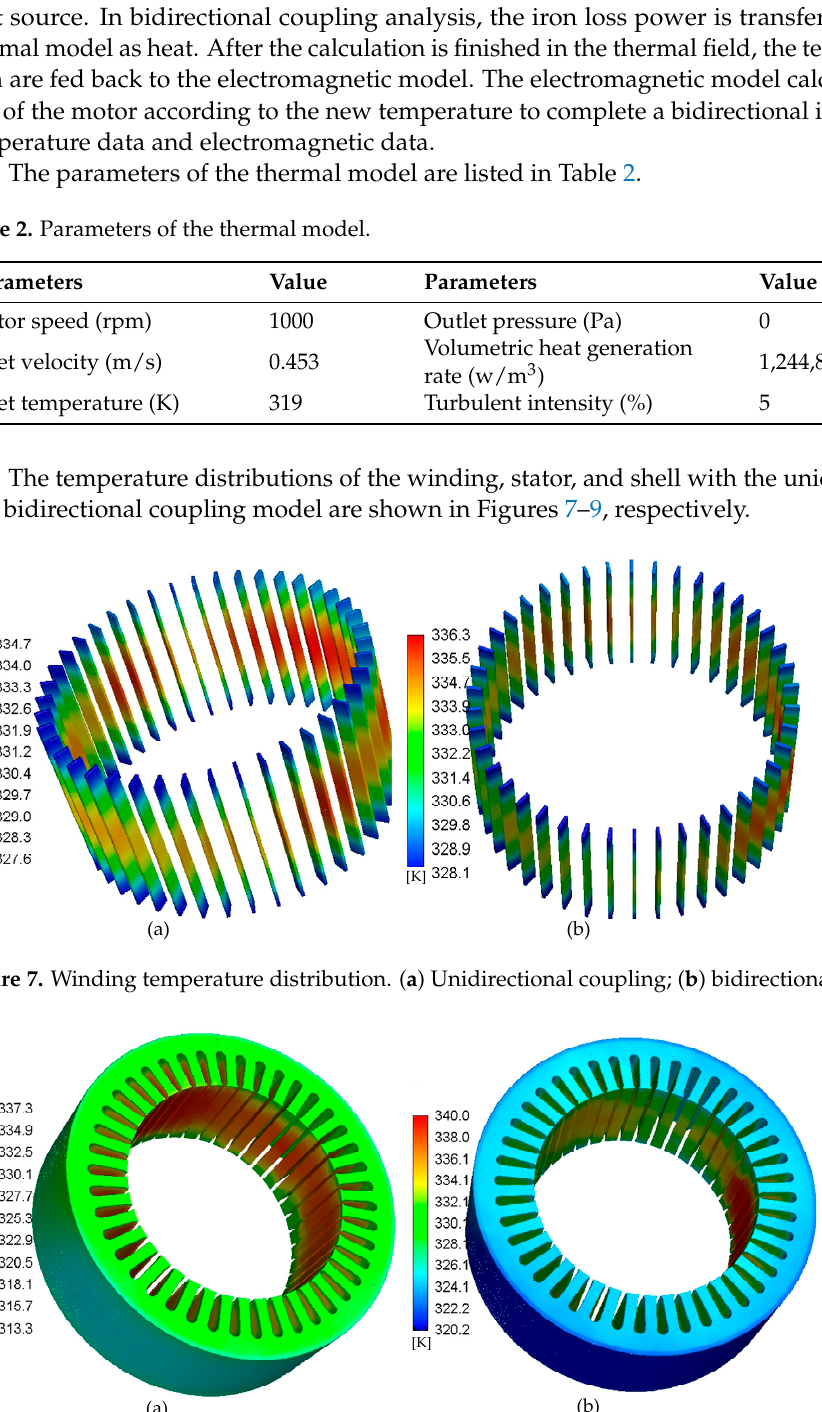
[K] Figure 9. Shell temperature distribution. ( a ) Unidirectional coupling; ( b ) bidirectional coupling. In Figure 7, due to the low thermal conductivity (0.2 W/m-k) of insulation filling glue around the winding, heat dissipation is difficult and the winding temperature rises greatly. The results show that the temperature of the bidirectional coupling model is about 1.6 °C higher than that of the unidirectional coupling model. In both models, there is no filling around the end winding; thus, heat dissipation is easier, so the temperature in the middle of the winding is higher than that in the endings. The temperature toward both